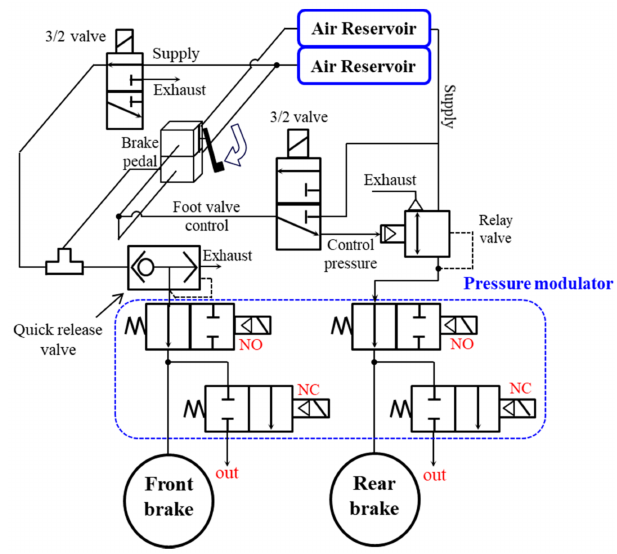
Figure 3. Pneumatic circuit of a commercial truck’s brake system.